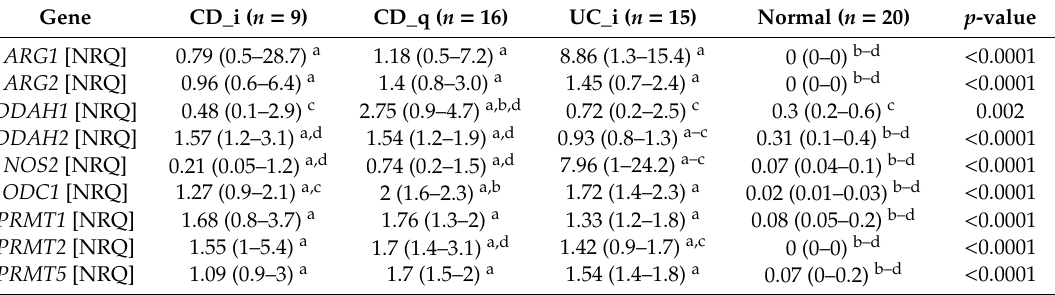
Table 5. L-arginine / NO pathway-associated enzymes in inflamed and quiescent large